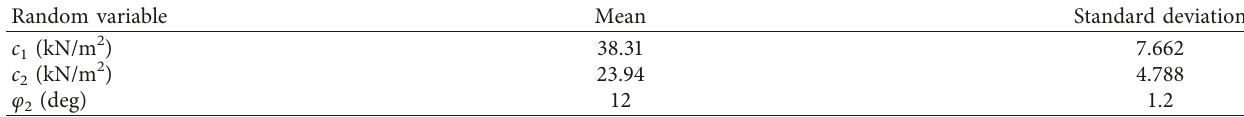
Table 4: Properties of stochastic variables of Example